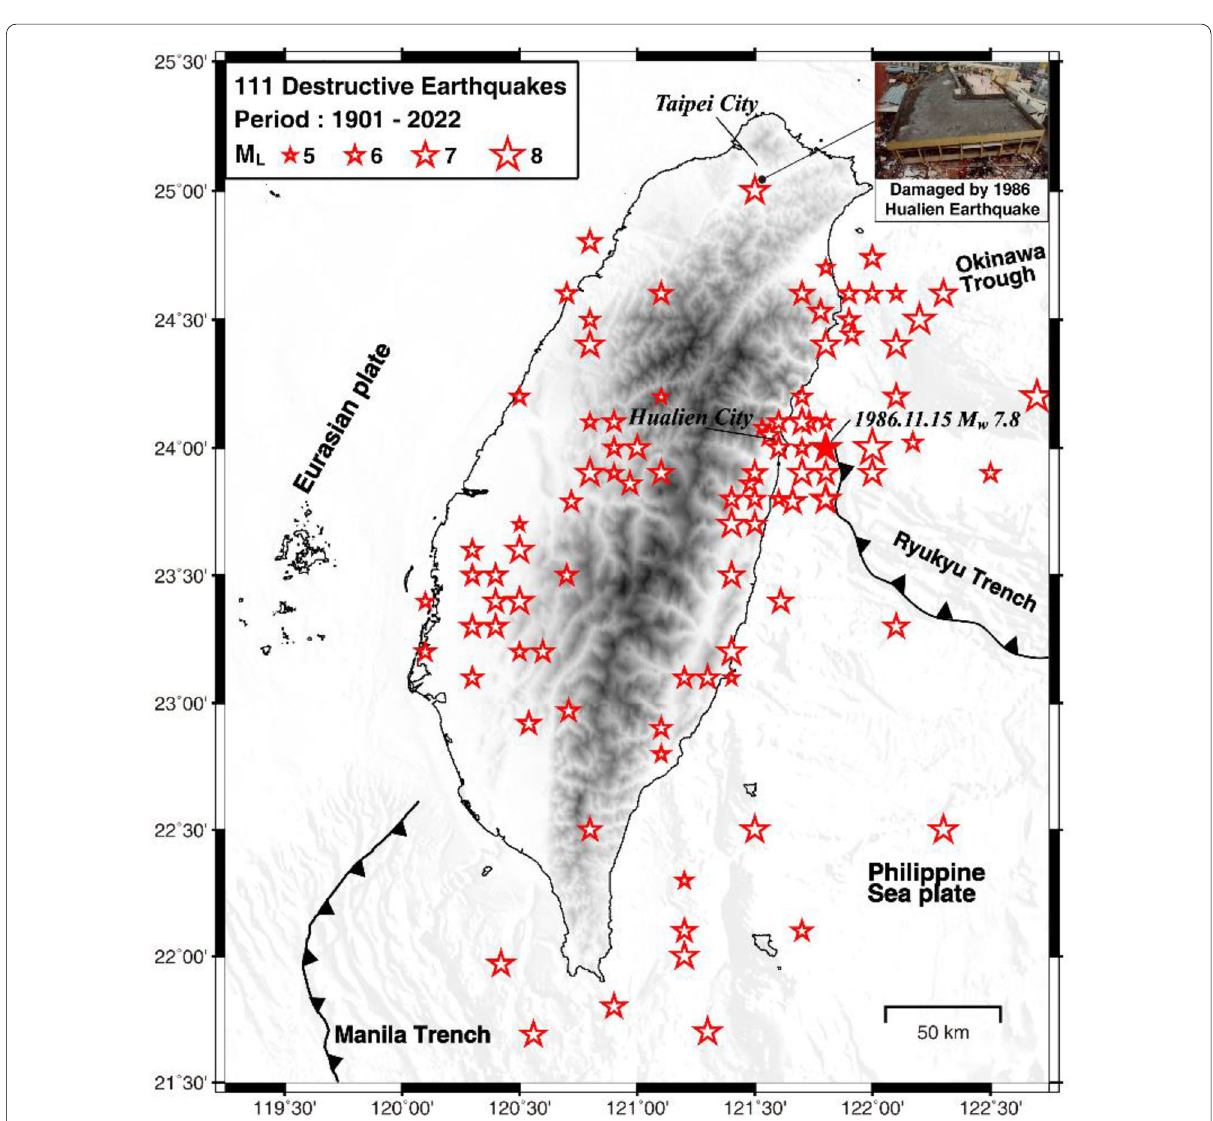
Fig. 1 Epicenter distribution of the damaging earthquakes that occurred in Taiwan since 1900. The solid red star shows the epicenter of 1986 M